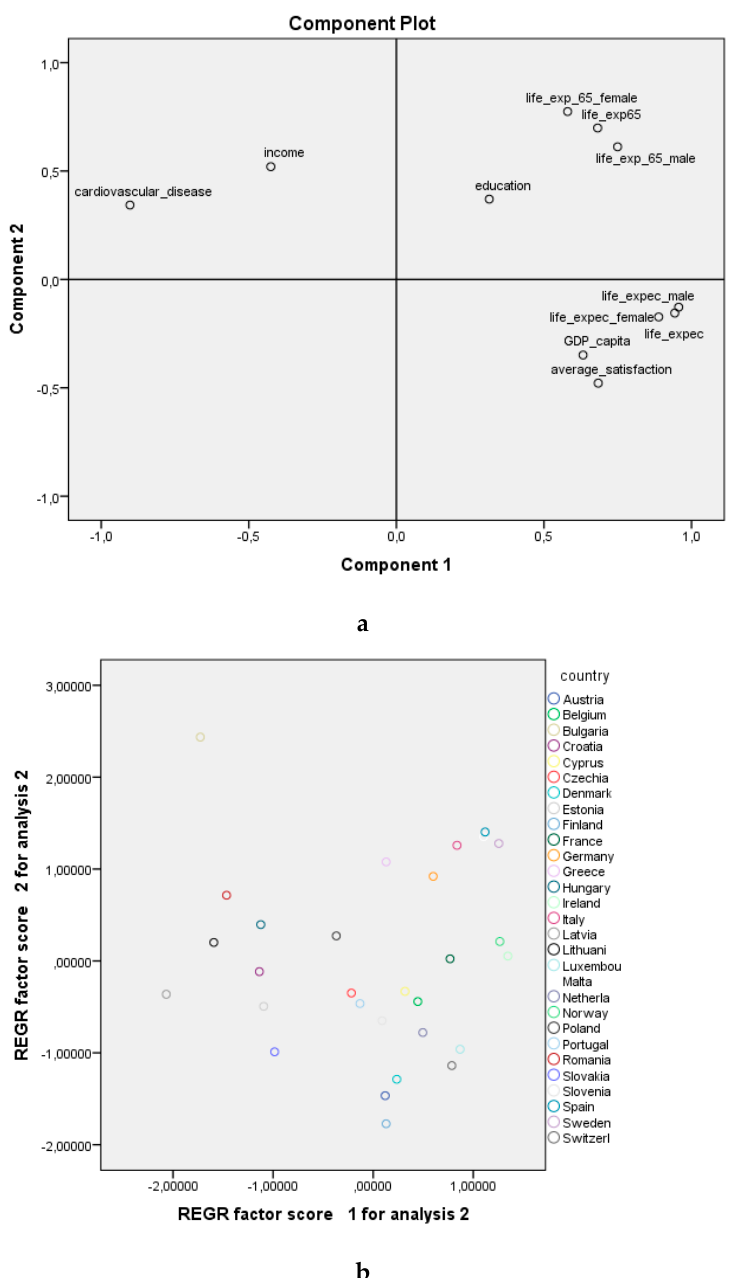
Figure 3. Graphical representation of variables ( a ) and countries ( b ) in the axis system. REGR— regression.